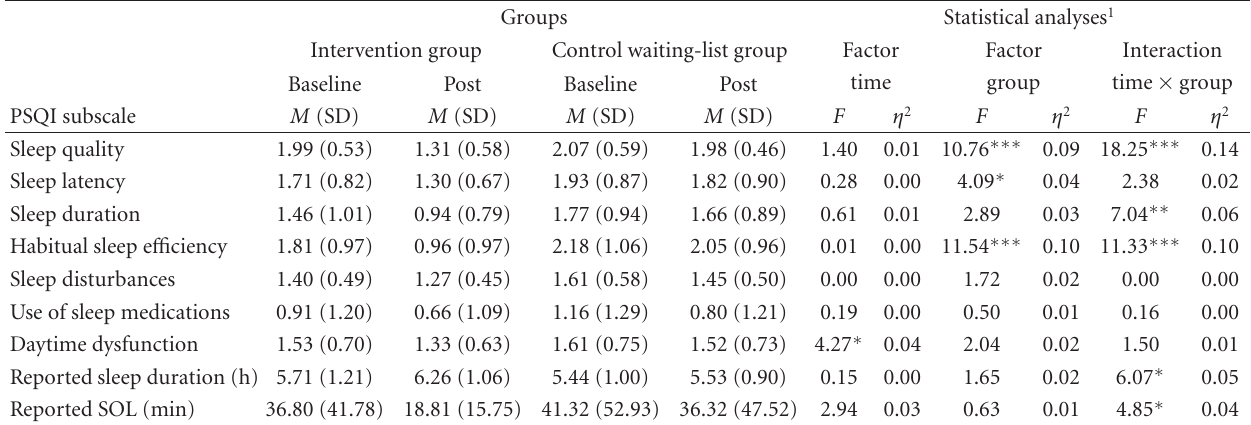
Table 2: Model estimated means ( M ), standard deviation (SD) and Time × Group e ff ects for the PSQI subscales.